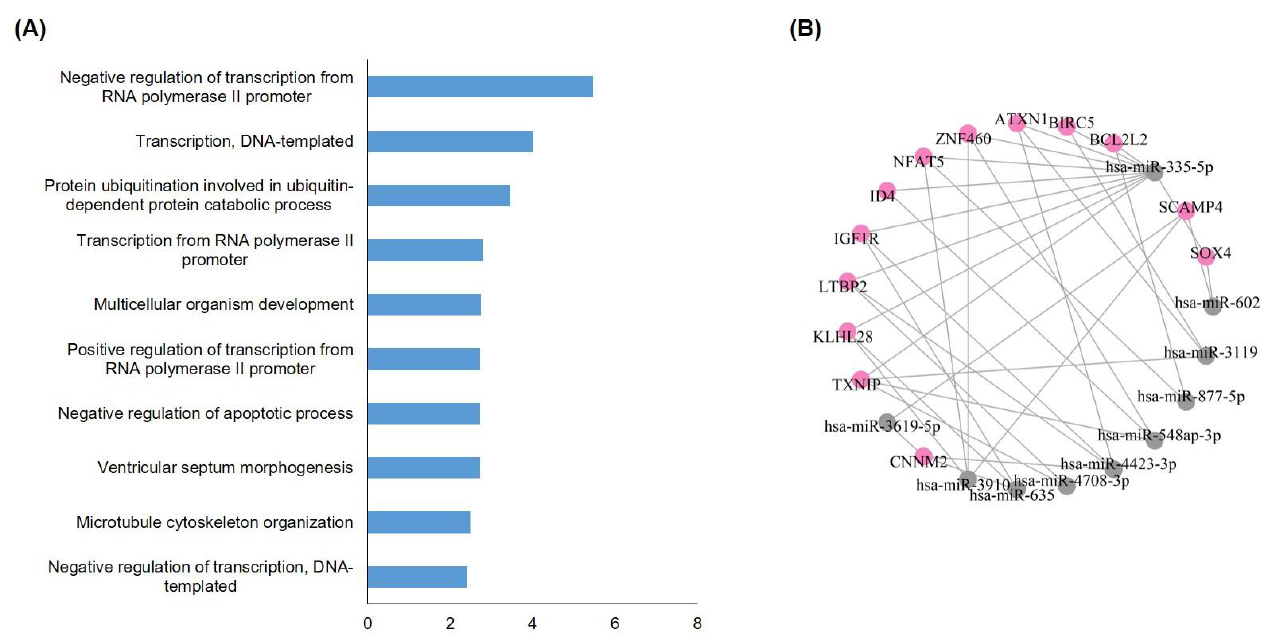
Figure 6. LM discriminative miRNA target gene enrichment analysis. Selected differentially expressed miRNAs between LM and BM of a primary cancer of non-small cell lung cancer predict ( A ) enriched molecular pathways by Gene Ontology, and ( B ) their target genes.